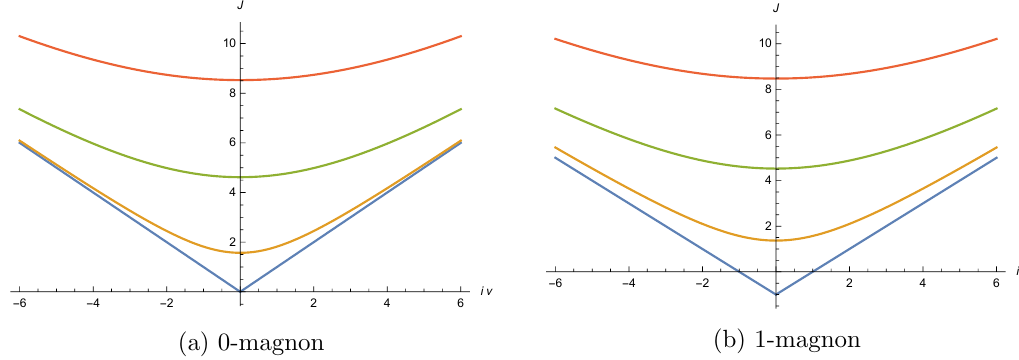
Figure 2. Leading Regge trajectories for 0 and 1 magnon correlators in the weak coupling. The chosen values of couplings are (cid:24) = 0 (blue), (cid:24) = 0 : 03 (orange), (cid:24) = 0 : 07 (green), (cid:24) = 0 : 12